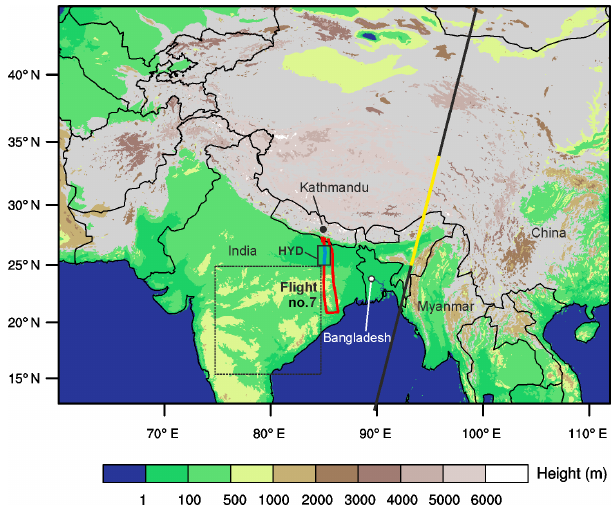
Figure 1. Topography and domain considered in the Meso-NH nu- merical simulation with a resolution of 2.5km. The trajectory of the Geophysica flight no. 7 to the south of Kathmandu is shown by the red solid line, while the pathway of moist patch (25–26.5 ◦ N) is depicted by the blue line. A black box “HYD” is a model do- main considered in comparison with aircraft measurement. Another box with dashed line is a model domain used to calculate the back- ground water vapour at 06:00UTC on 8 August 2017. The track of CALIOP at around 20:00UTC on 7 August 2017 is shown by the black solid line, while its track between 25 and 33 ◦ N is highlighted in